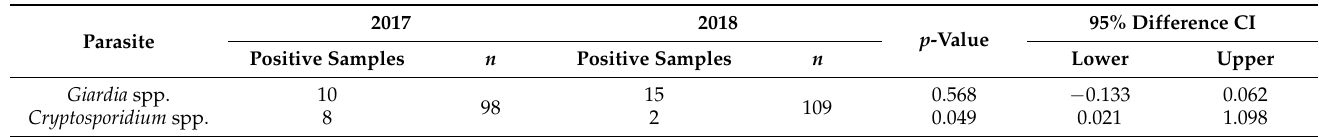
95% Difference CI p -Value